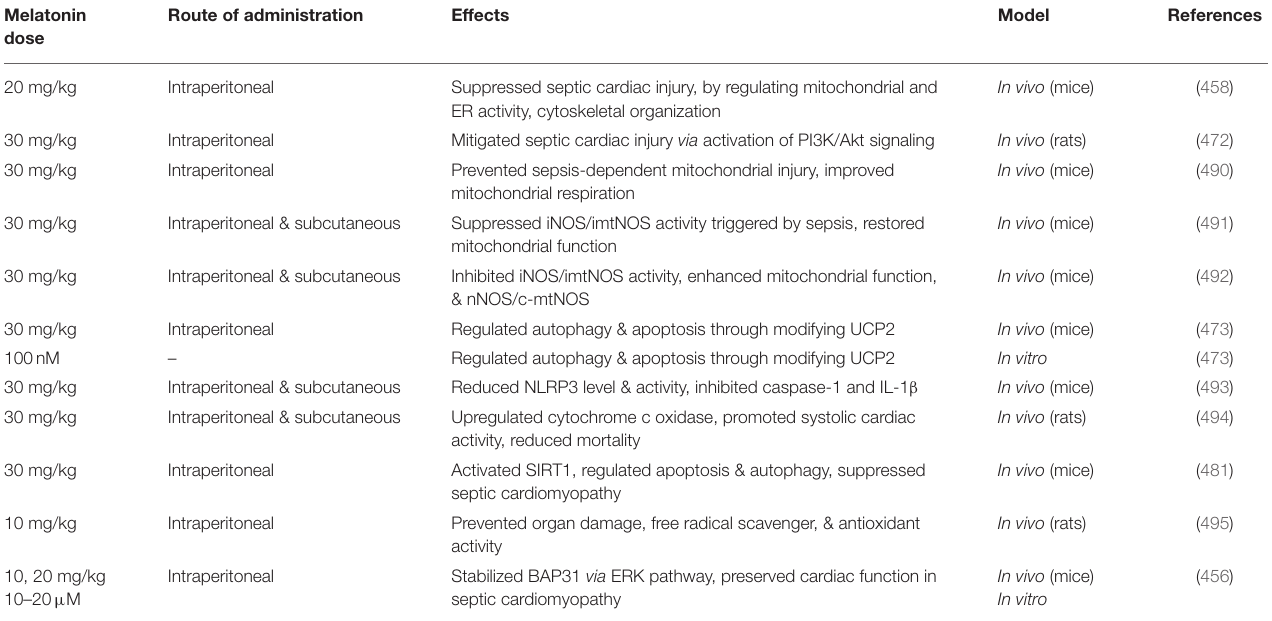
TABLE 7 | Effects of melatonin on septic cardiomyopathy. Melatonin